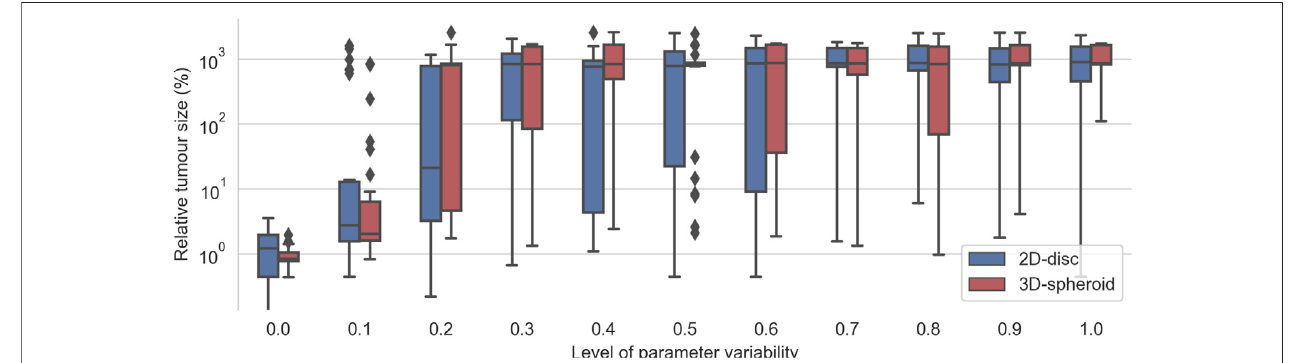
FIGURE 6 | Evaluation of the top 30 best effective treatments in heterogeneous populations of cancer cells with different degrees of variability in the kinetic parameters of the TNFR. For a given value kinetic parameters ’ variability ( x -axis), each pair of boxes depicts the distribution % of alive cells at the end of the simulations obtained after evaluating the top 30 best effective treatments founded when zero variability was considered.